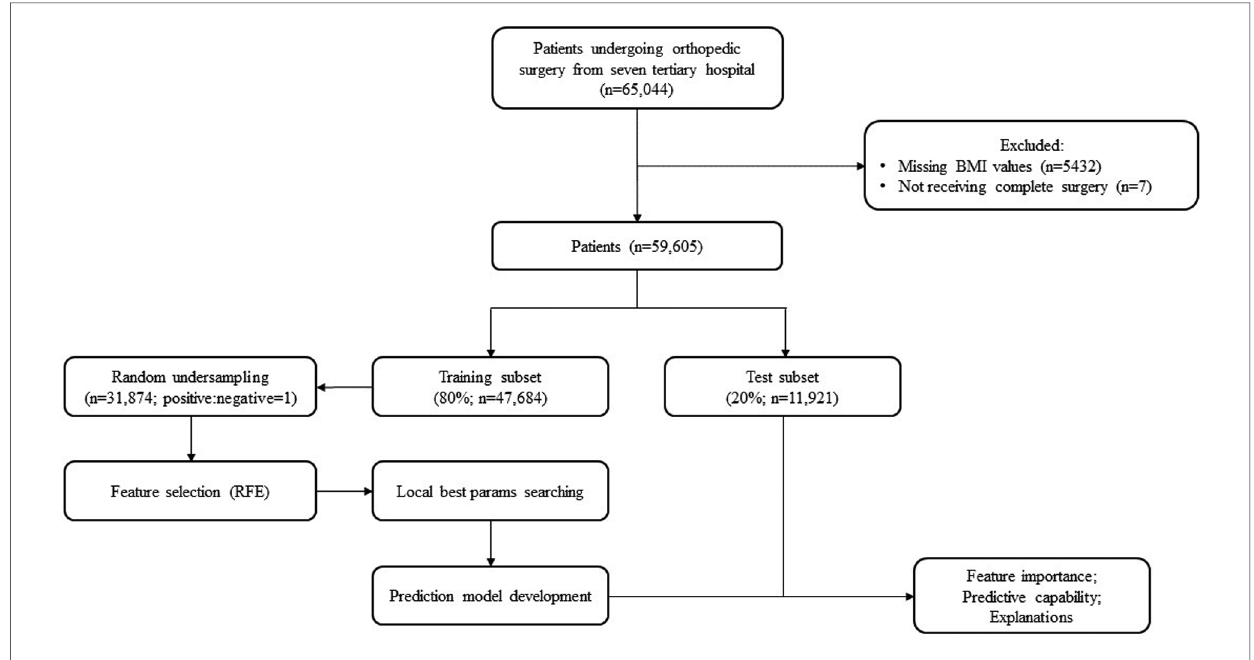
FIGURE 1 Flowchart of the study